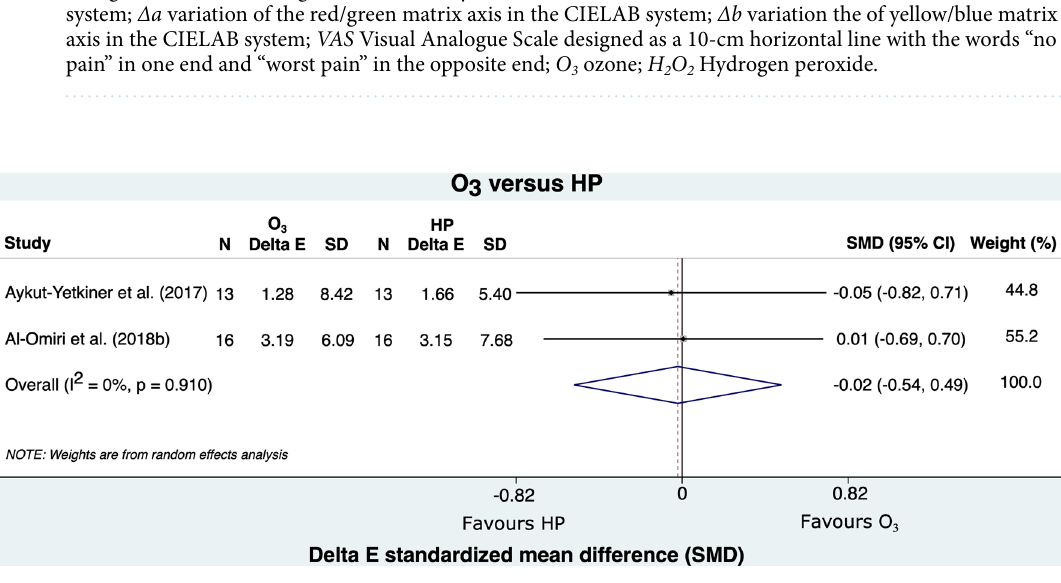
Figure 2. Forest plot of color change comparing group O 3 to group HP.